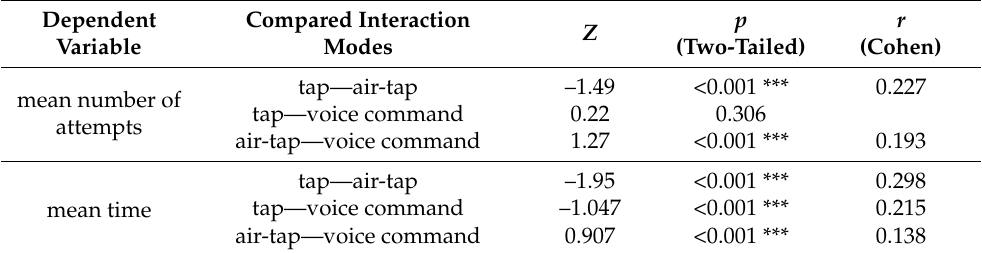
Table 2. Pairwise Dunn-Bonferroni post-hoc comparisons for the efficiency assessment.